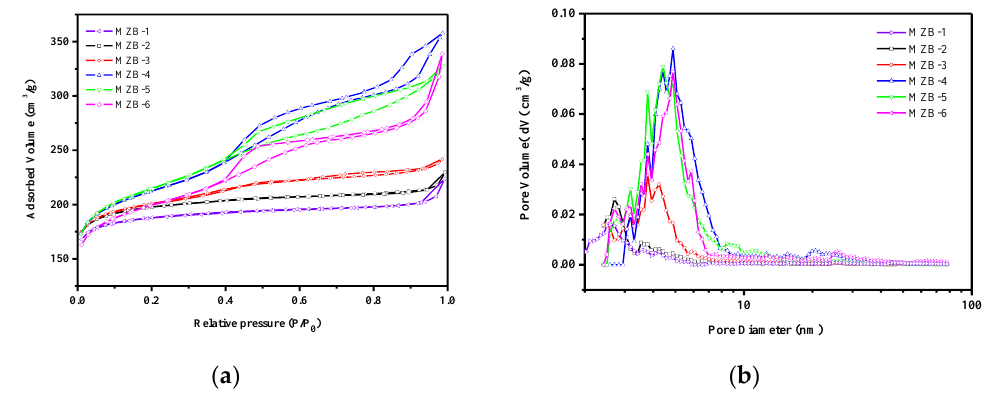
Figure 2. N2 adsorption-desorption isotherms of synthesized zeolite Beta samples ( a ) and pore distribution ( b ).